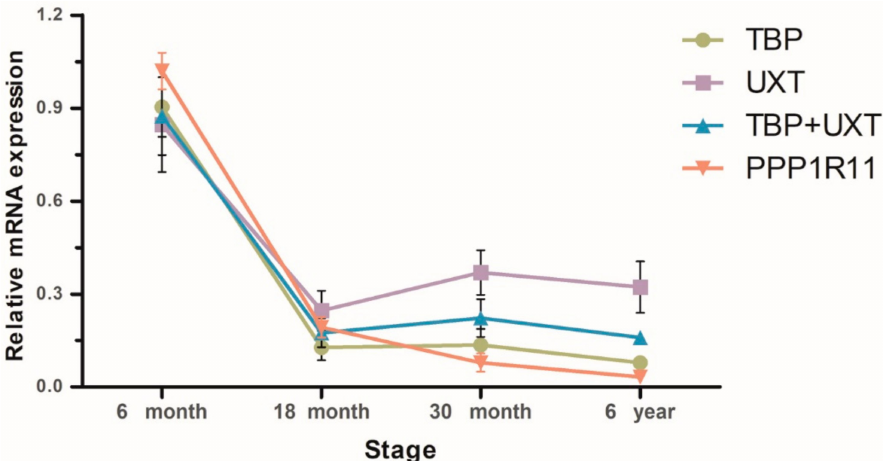
Figure 3. The expression pattern of the TET2 mRNA in the whole developmental stage of yak testis. The expression patterns were normalized using TBP , UXT, or PPP1R11 as RGs singly and with the mean of TBP + UXT